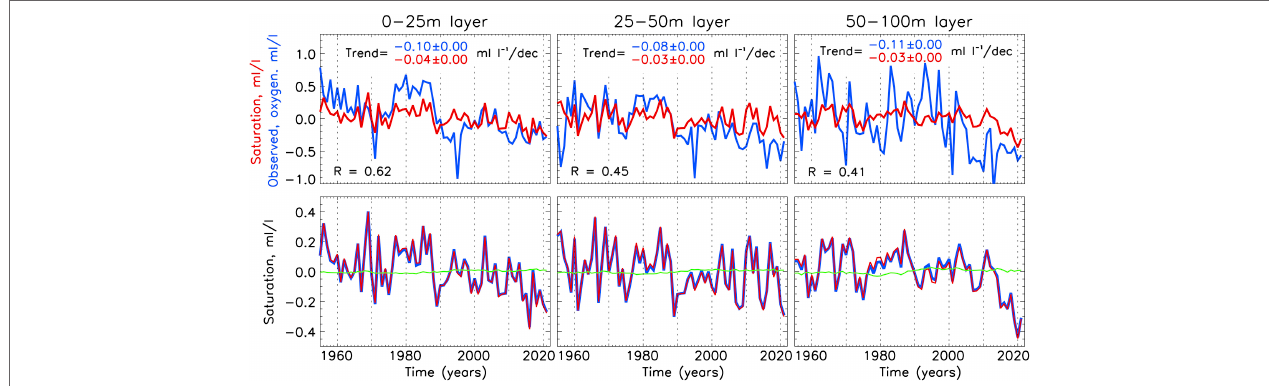
FIGURE 7 | (Top) Time series of the observed oxygen concentrations (mL L -1 , blue) and expected oxygen saturation (mL L -1 , red) anomalies from shipborne and glider observations in the Bothnian Sea. (Bottom) Time series of the observed oxygen concentrations (blue), expected oxygen saturation anomalies due to temperature (red) and salinity (green).